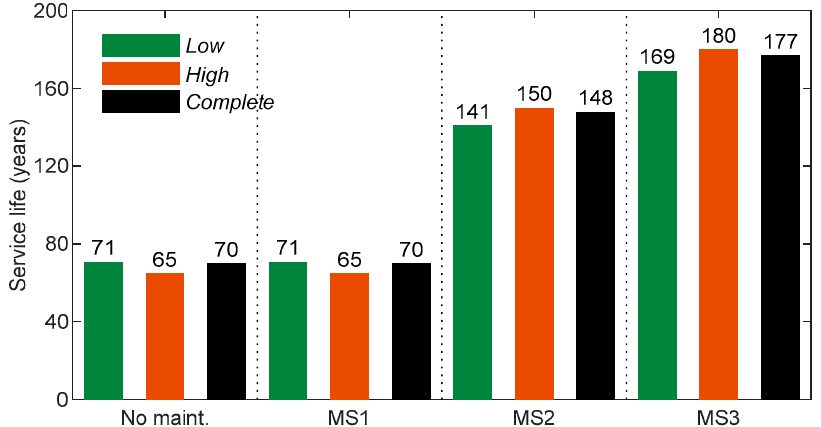
Figure 11. Comparison of the service life for both heights and for the complete sample.